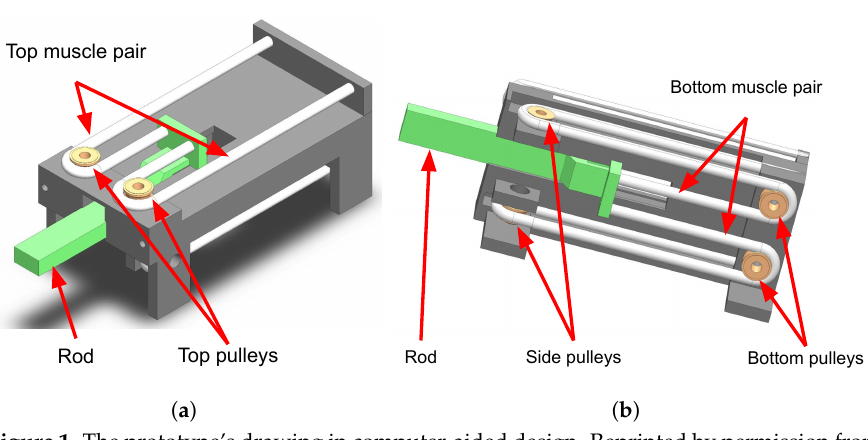
Figure 1. The prototype’s drawing in computer-aided design. Reprinted by permission from Springer Nature: Springer eBook [42], copyright 2022. ( a ) Isometric view of the top part; ( b ) Cross-section view of the bottom part. Table 2. Specifications of the TMM